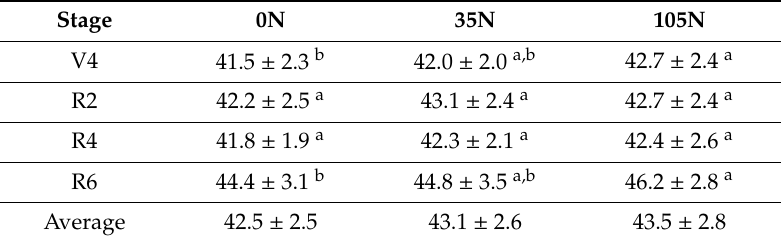
Table 1. The e ff ect of di ff erent fertilization rates on soil plant analysis development (SPAD) at di ff erent stages of soybean’s (cv. Pannonia Kincse) life cycle, averaged among 2017, 2018 and 2019 in Debrecen, Hungary.